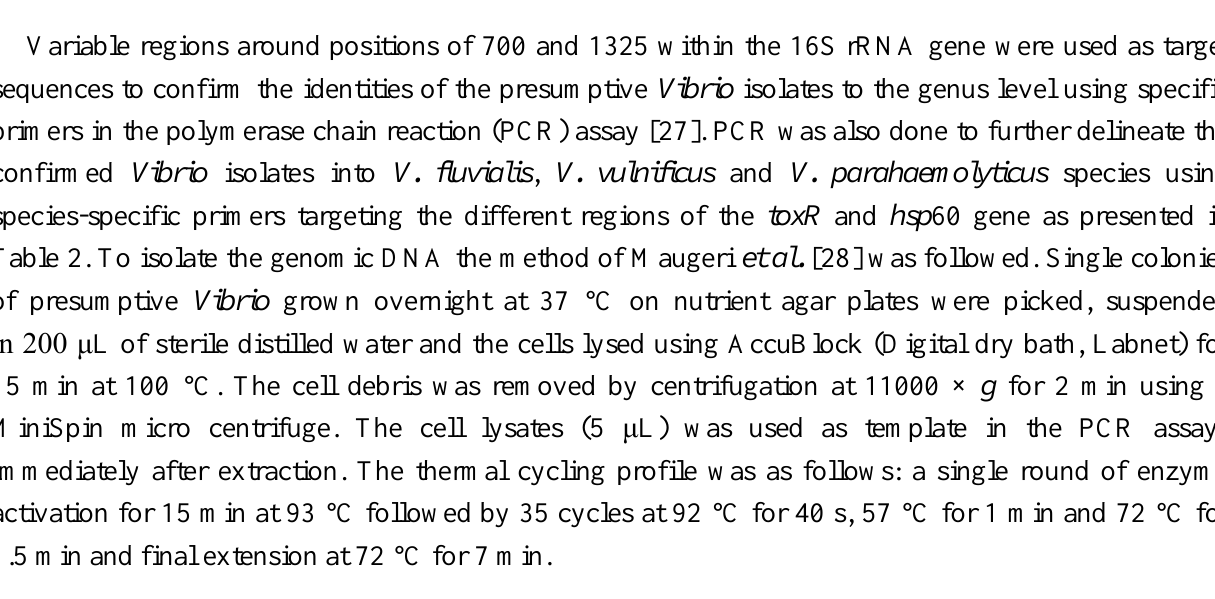
Table 2. Sets of primers used for identification and pathotyping of Vibrio